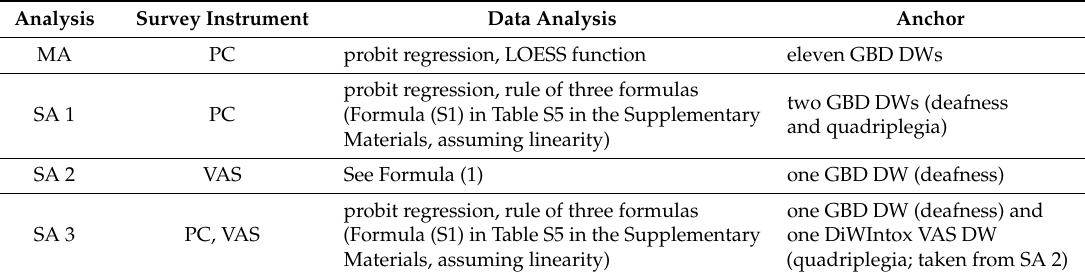
Table 2. Approaches to derive disability weights in main analysis and scenario